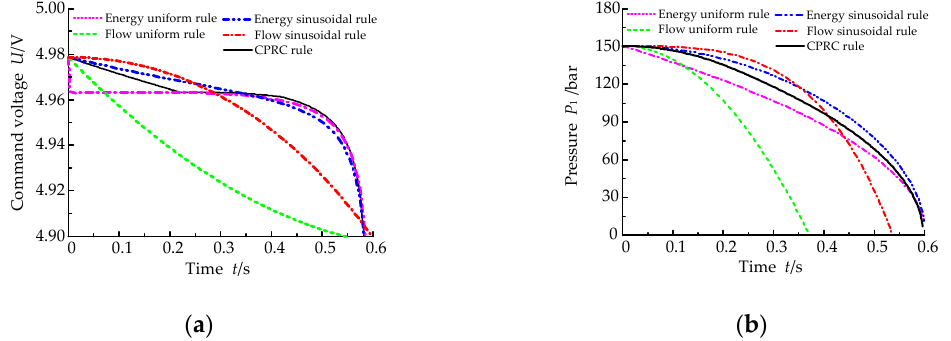
Figure 9. The simulation curve under the different pressure-relief rules under initial pressures of 150 bar. ( a ) Eccentric magnitude curve; ( b ) Pressure-relief curves.